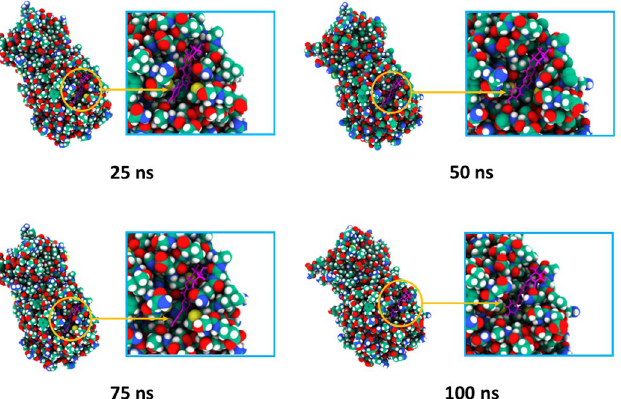
Fig 4. Surface view of the docked complexes in molecular dynamics simulation. The snapshots were acquired at 25, 50, 75, and 100 ns for the Cosmosiine and Mpro complex.